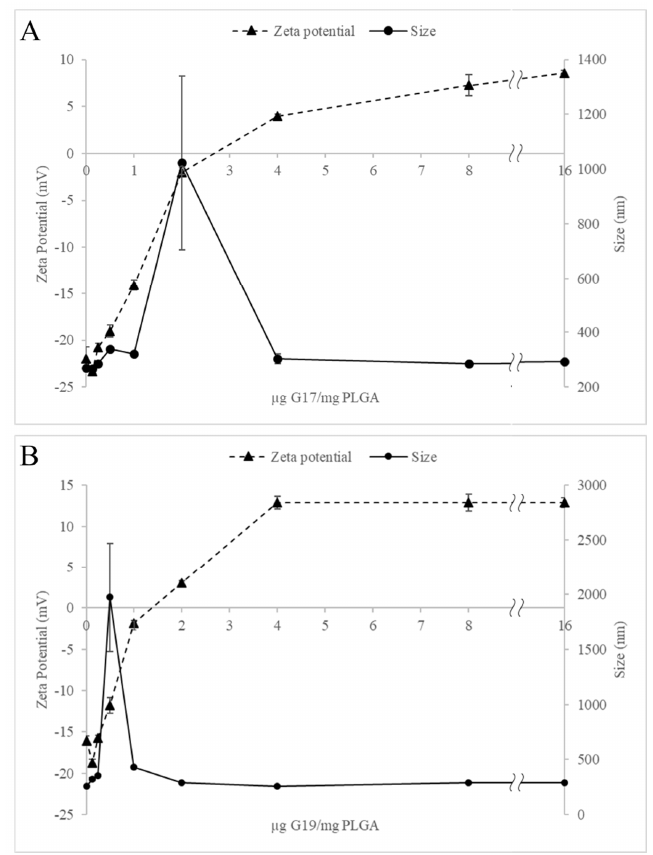
Figure 1. Effect of the peptide/polymer ratio on zeta potential and size of G17NP ( A ) and G19NP ( B ). ff ect of the peptide / polymer ratio on zeta potential and size of G17NP ( A ) and G19NP ( B ). Data are the mean ± SD (n = 3). Figure 1. E Data are the mean ± SD ( n =